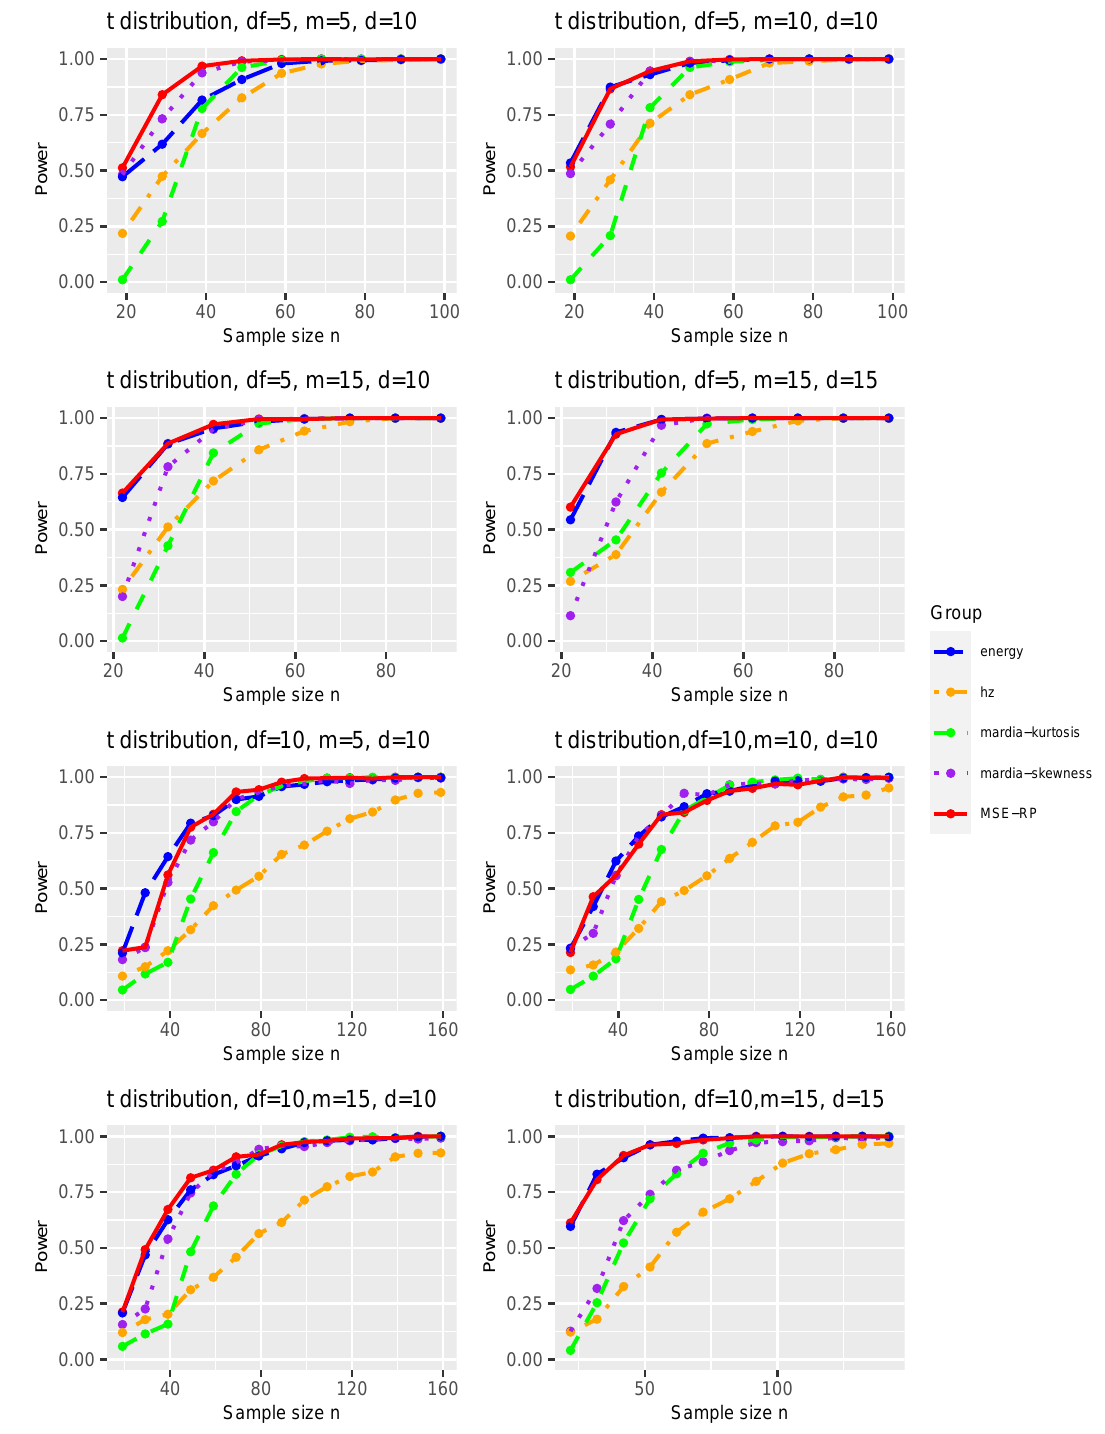
Figure 6. Power ( α = 0.05) comparison in multivariate t